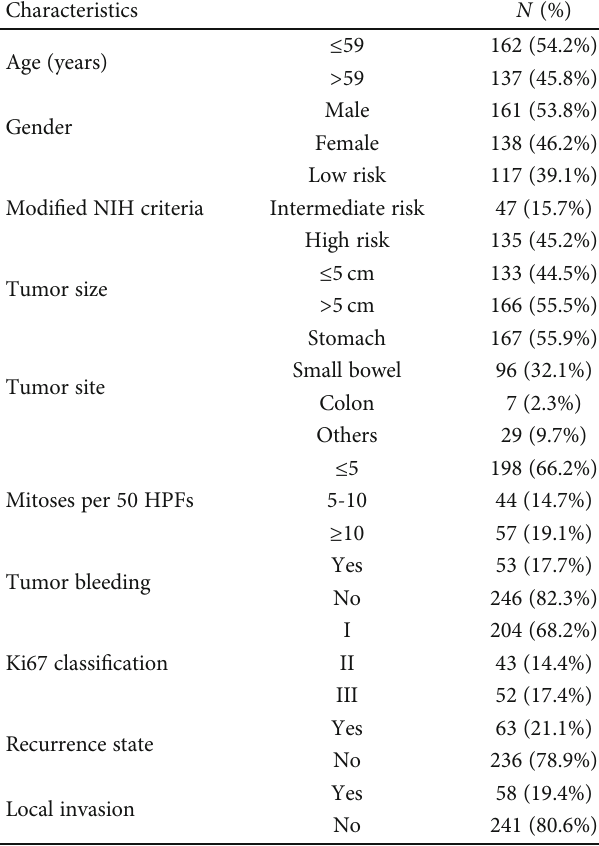
Table 1: Clinicopathological characteristics of GIST patients ( N = 299